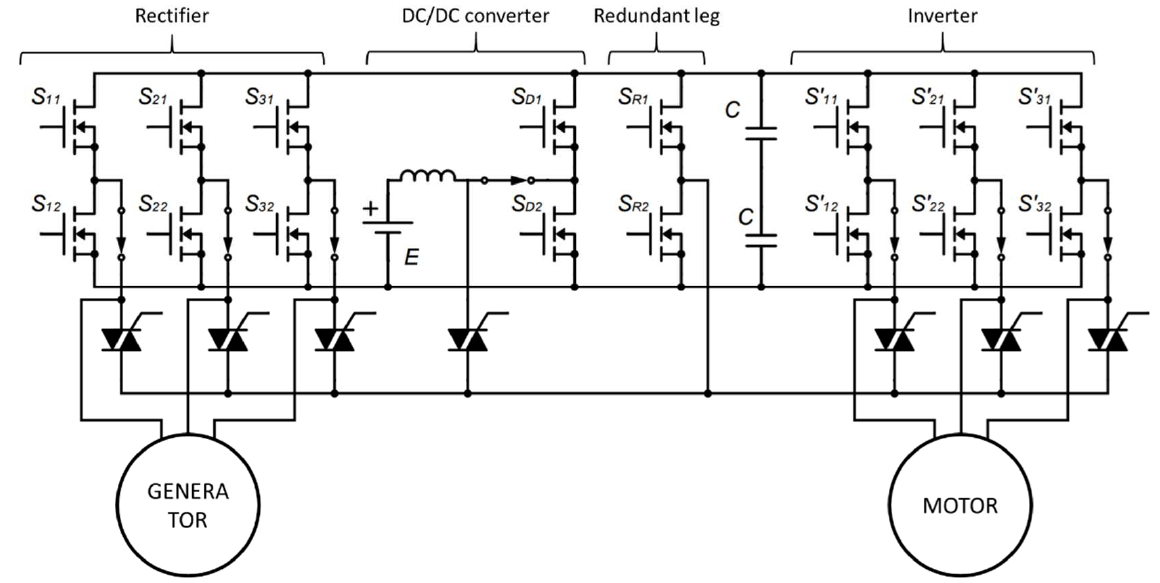
Figure 11. Redundant leg shared between rectifier, buck/boost converter and inverter for HEV application [78].